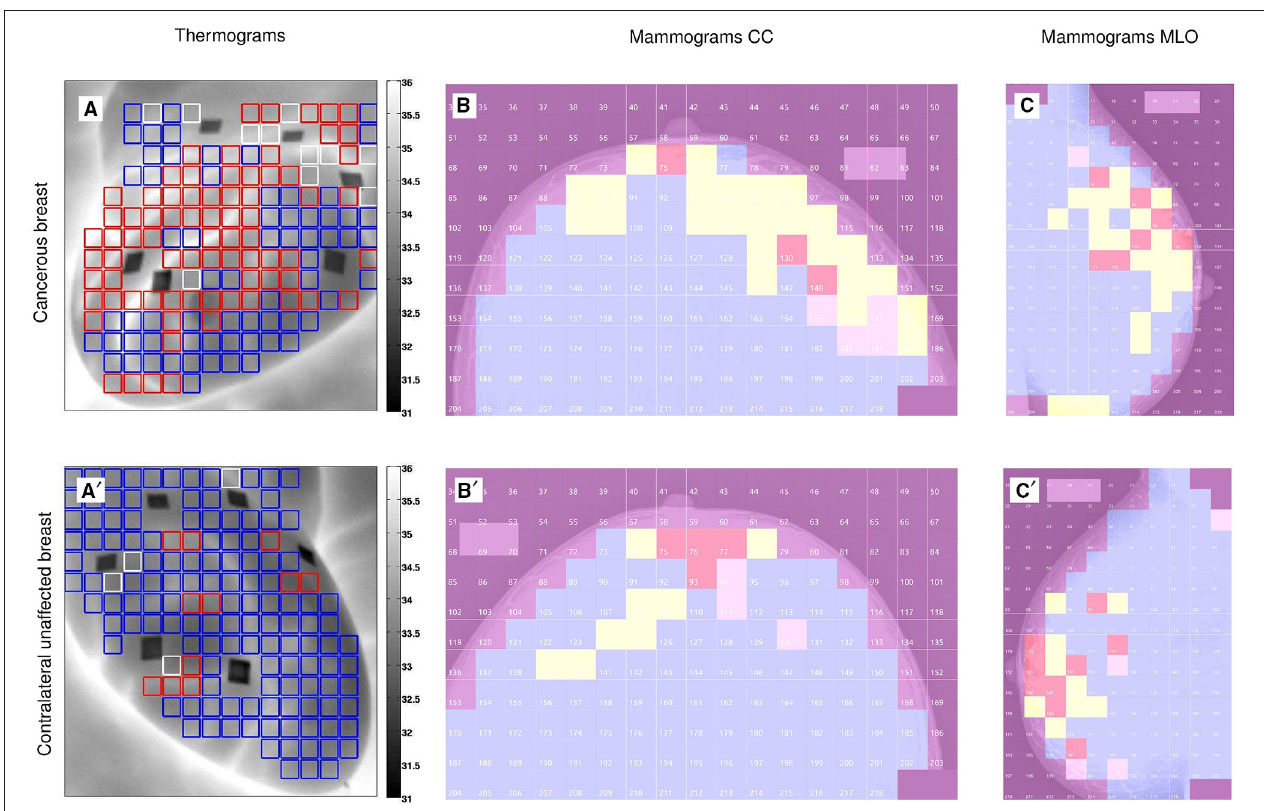
FIGURE 1 | Wavelet-based multifractal segmentation of dynamic infrared thermograms and X-ray mammograms. Patient 20 (age 56): cancerous right breast (A–C) and contralateral unaffected left breast (A ′ –C ′ ) . (A,A ′ ) As estimated from the τ ( q ) spectrum of skin temperature temporal fluctuations computed with the 1D WTMM method ( Figures 2D–F ), 8 × 8 pixel 2 squares spanning 10 × 10 mm 2 were color coded according to monofractal ( c 2 < 0.03, red), multifractal ( c 2 ≥ 0.03, blue) and no scaling (white) diagnostic, where c 2 is the intermittency coefficient that defines the width of the D ( h ) singularity spectrum (Equations 10, 11)